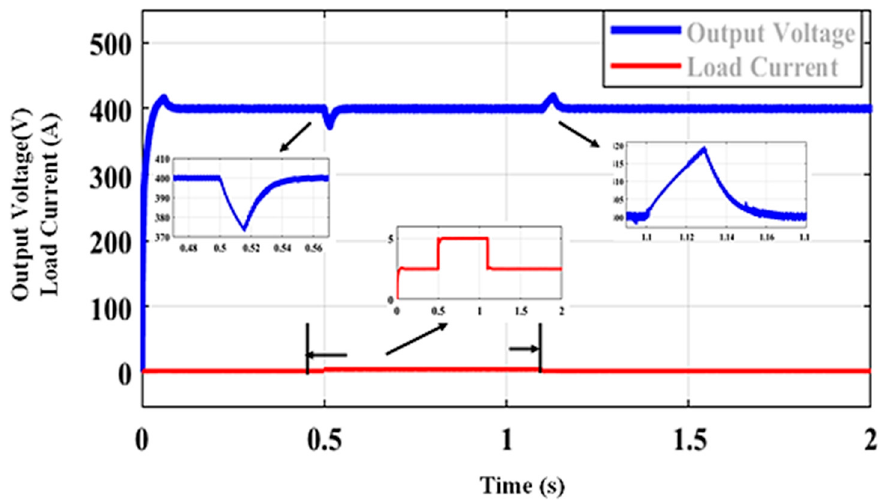
Figure 12. HG-SIQBC-output voltage and current when subjected to a load change for V in = 75 V.